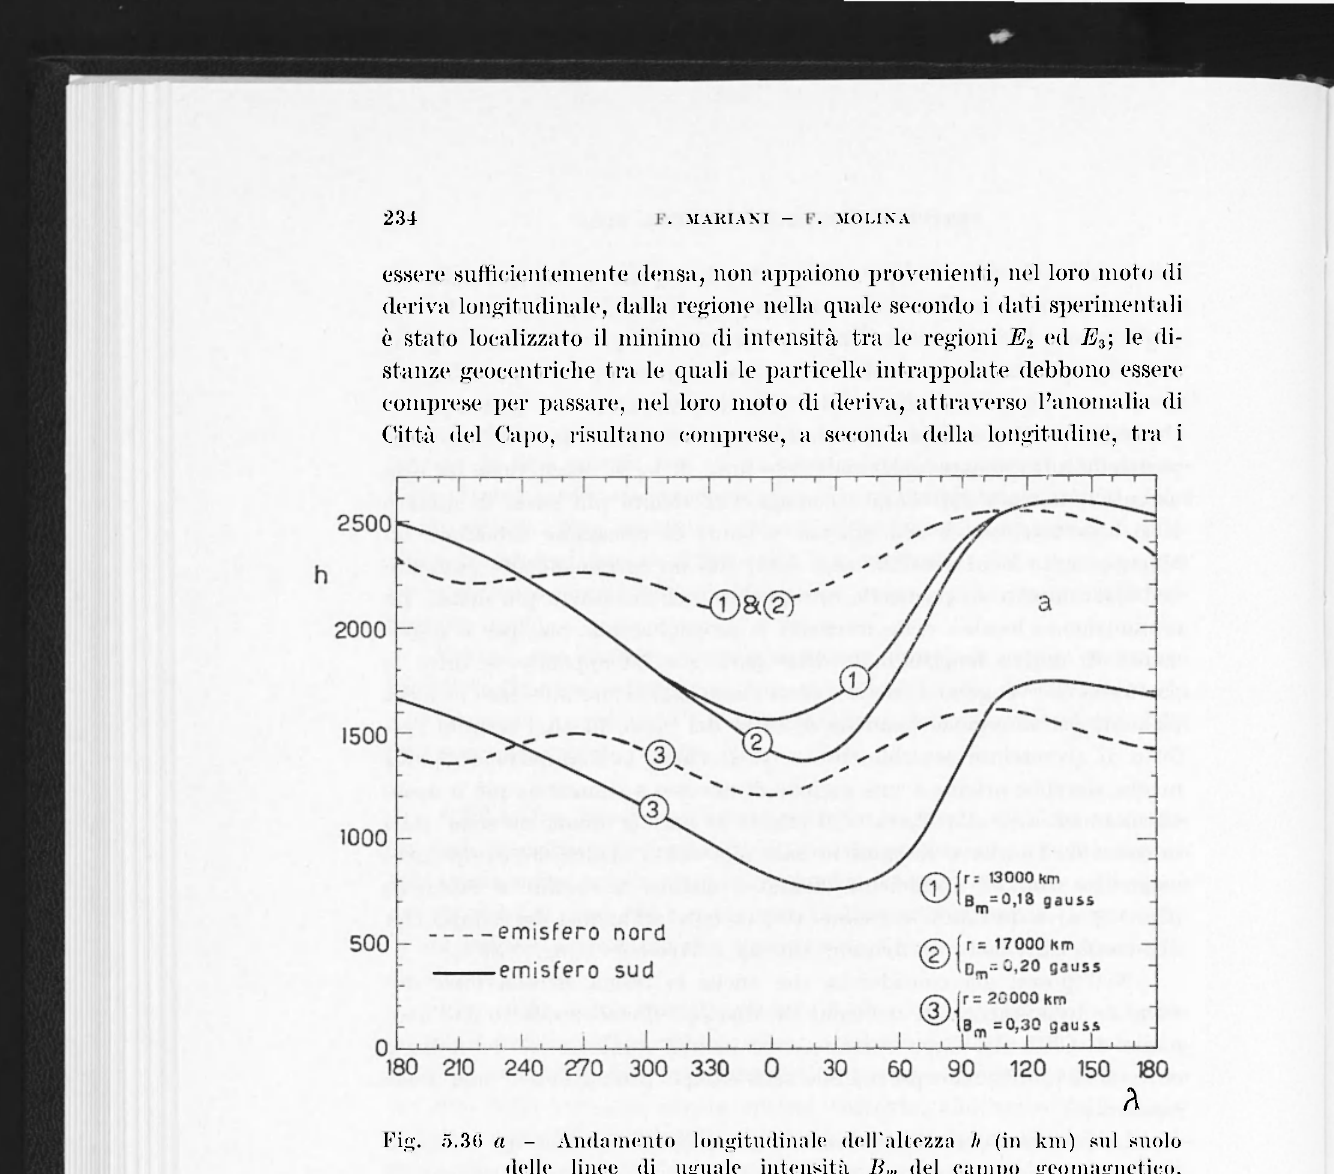
Fig. 5.36 a - Andamento longitudinale dell'altezza li (in km) sul suolo delle linee di uguale intensità B m del campo geomagnetico, nell'emisfero nord e nell'emisfero sud; le tre linee per ciascun emisfero si riferiscono a tre diverse distanze geocentriche r delle linèe di forza nel piano equatoriale (secondo Dessler e Karplus);